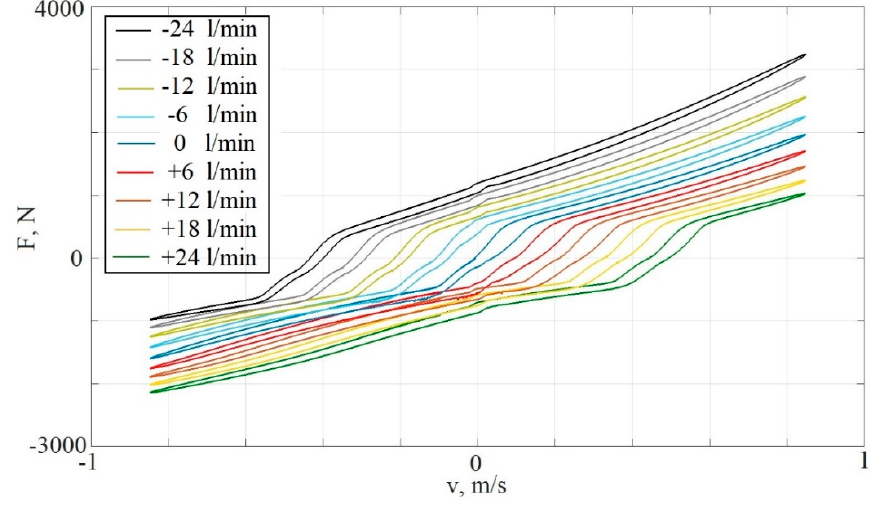
Figure 3. Active shock absorber dissipative characteristics set with different values of the flow rate 𝑄 .